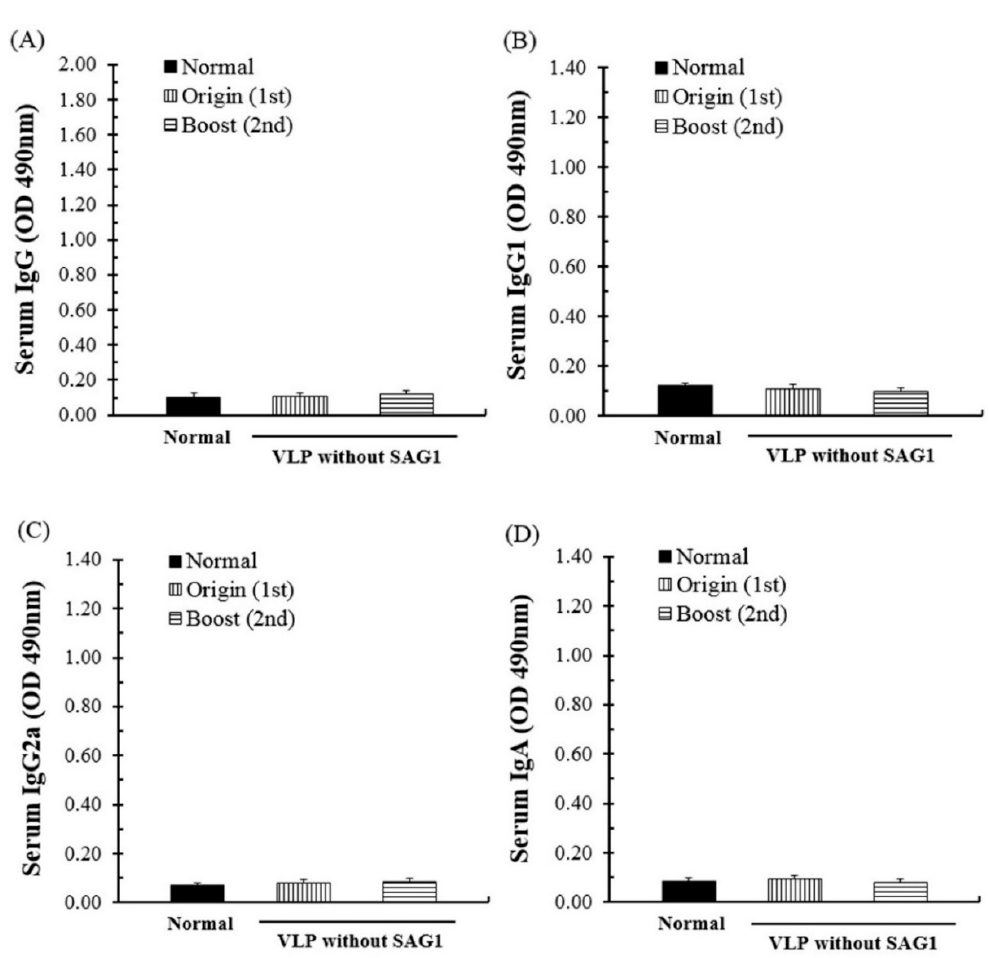
Figure 6. T. gondii antibody response after the immunization of VLPs alone without the SAG1 antigen. The sera of mice were collected at 4 weeks after the first and second immunization, respectively. ( A ) IgG, ( B ) IgG1, ( C ) IgG2a, and ( D ) IgA antibody responses were evaluated using the sera at the time point, respectively. The groups were divided as follows: the immunization step: the normal group and immunization group (the group immunized with VLP alone, without SAG1).